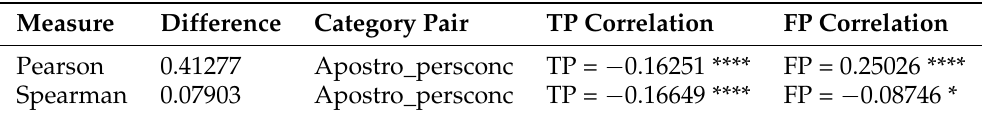
Table 49. Apostrophes and Personal concerns in High.